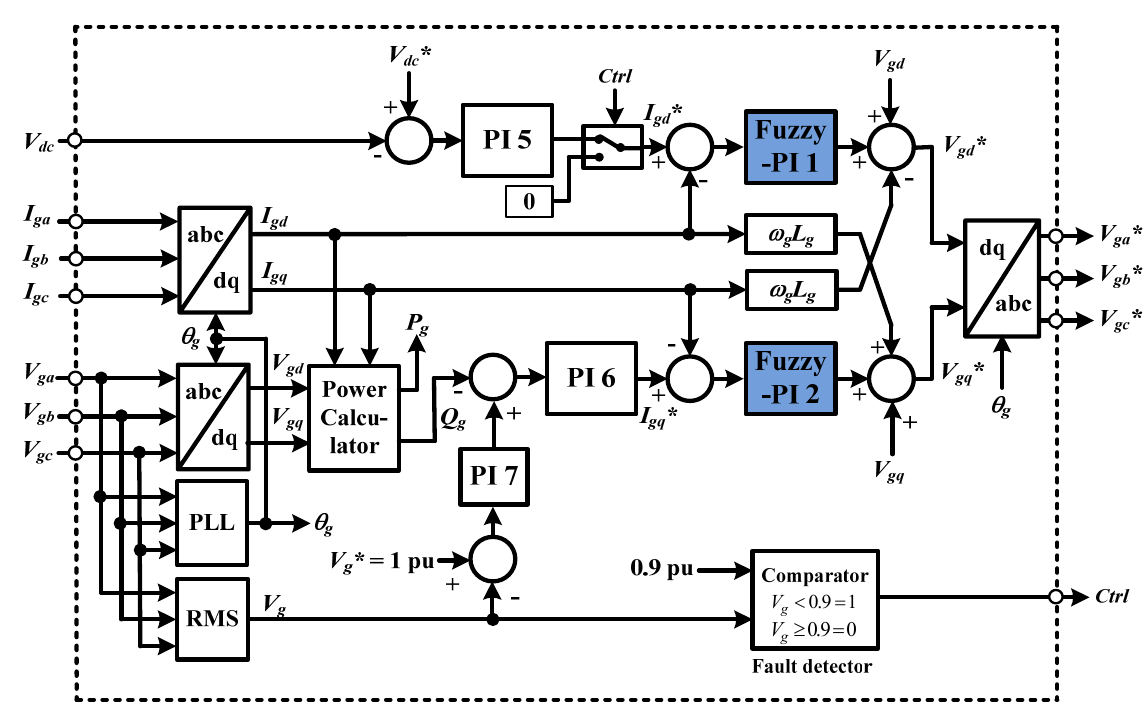
Figure 9. Grid side controller